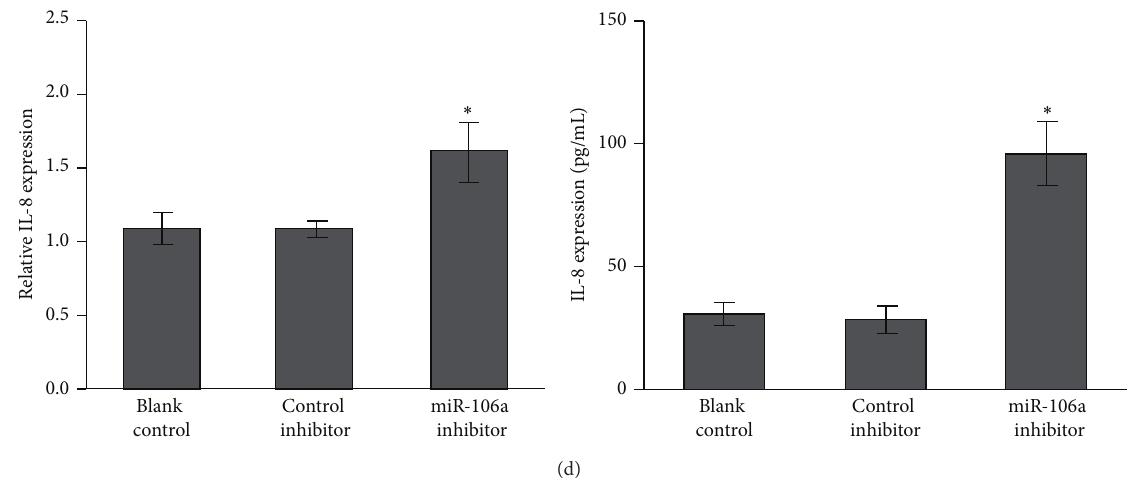
Figure 3: IL-8 is a direct target of miR-106a. (a) Up: potential sites in IL-8 3 󸀠 UTR targeted by miR-106a. 3 󸀠 UTR of IL-8 was cloned into a luciferase reporter vector. Mutated sequences were generated in the seed regions to abolish binding of the corresponding miRNAs. Down: HEK293 cells were cotransfected with miR-106a mimics or inhibitor and the luciferase reporter constructs harboring IL-8 or mutant IL- 8 3 󸀠 UTR fragments. The luciferase reporter assays were performed 48 h after transfection. The luciferase activities were measured and normalized to a Renilla luciferase activity. (b) miR-106a expression level was determined after transfection with miR-106a mimics or inhibitor. (c) IL-8 mRNA and protein levels after transfection with miR-106a mimics were assessed by qRT-PCR and ELISA. (d) IL-8 mRNA and protein levels after transfection with miR-106a inhibitor were assessed by qRT-PCR and ELISA. ∗ 𝑝 < 0.05 .